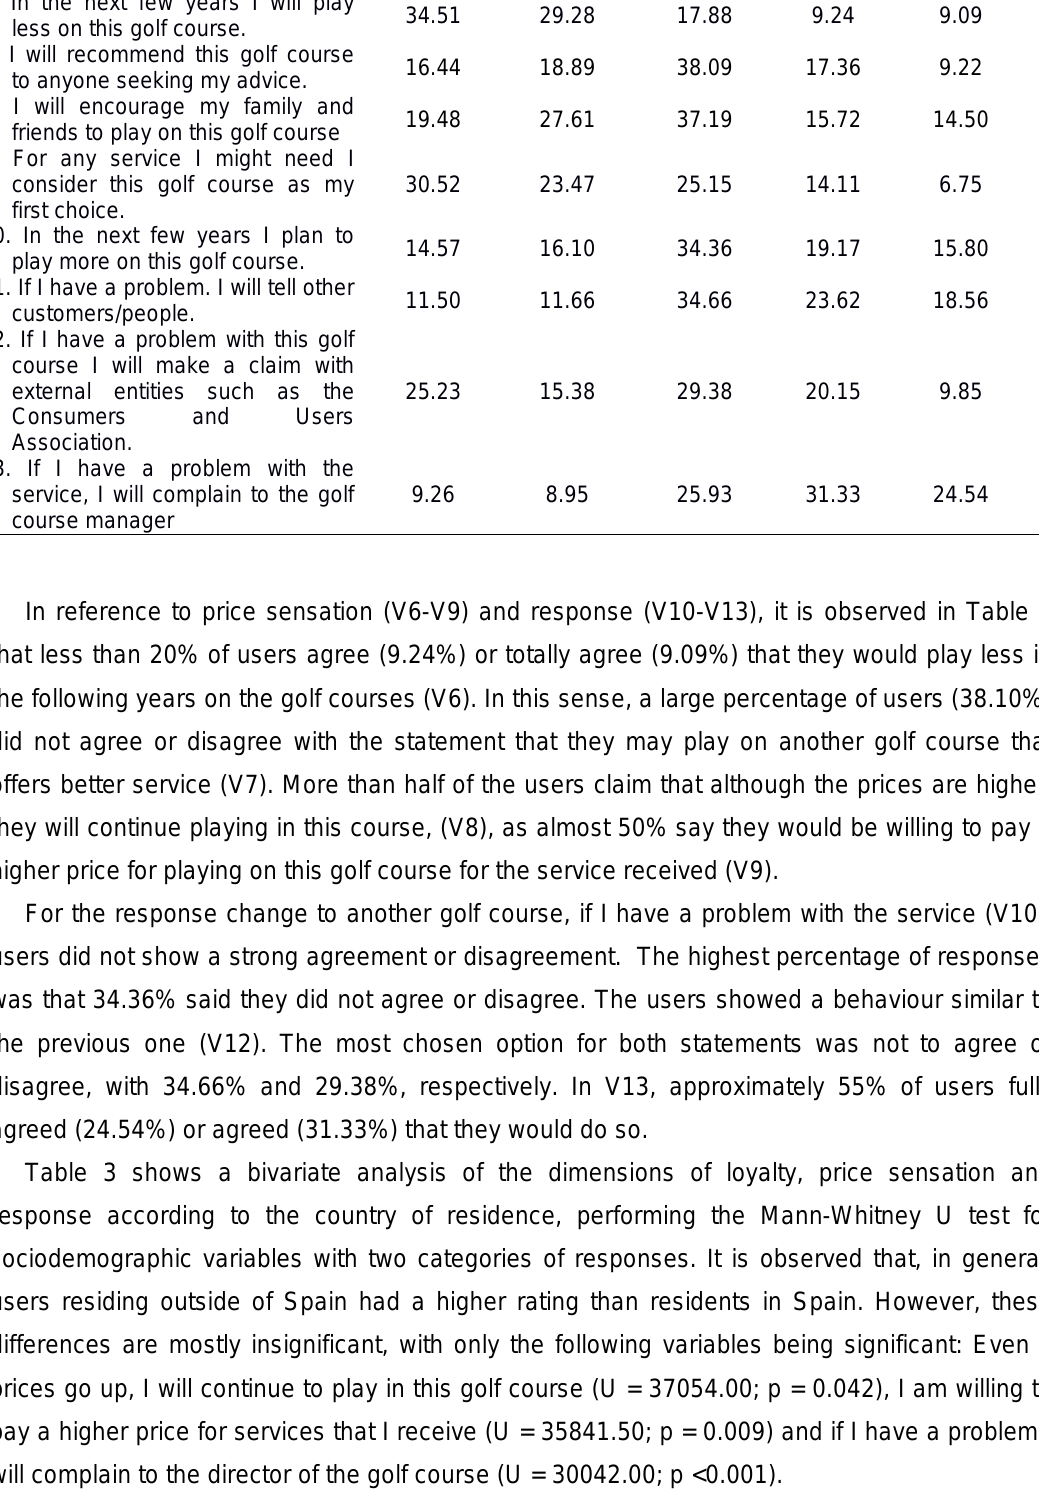
Neither agree nor disagree